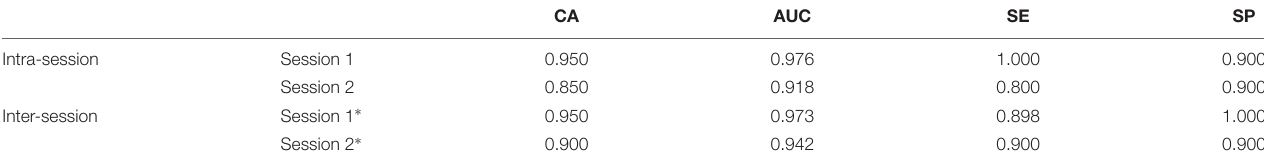
TABLE 2 | The classification results of SVM classifier.